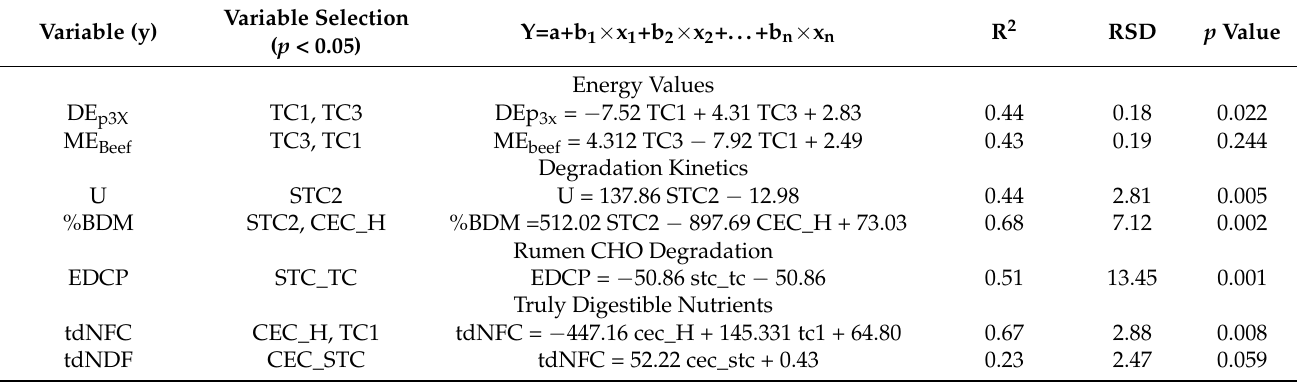
Table 5. Multiple Regression Analysis to Study Associations between Carbohydrate Spectral Param- eters and Chemical and Nutrient Profiles, Truly Absorbed Protein, Intestinal Protein Degradation, Rumen Degradation Parameters of Cool-Season Adapted CDC